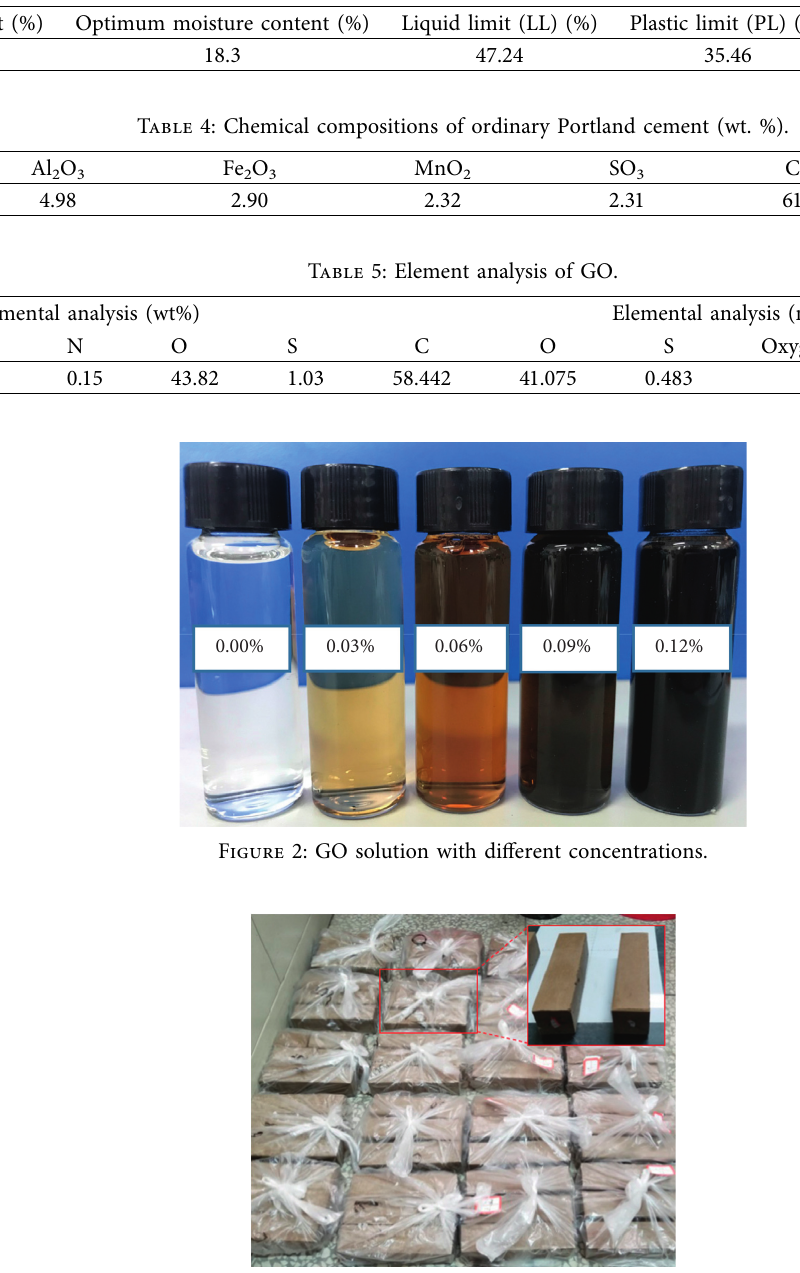
Table 3: Physical properties of the studied loess.